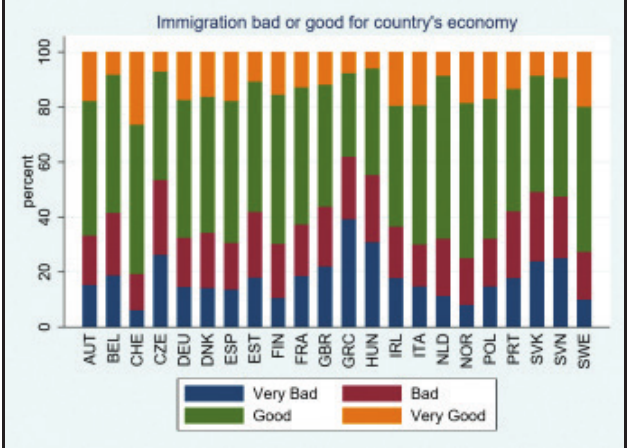
Figure A1 Country attitudes toward immigration is bad or good for country’s